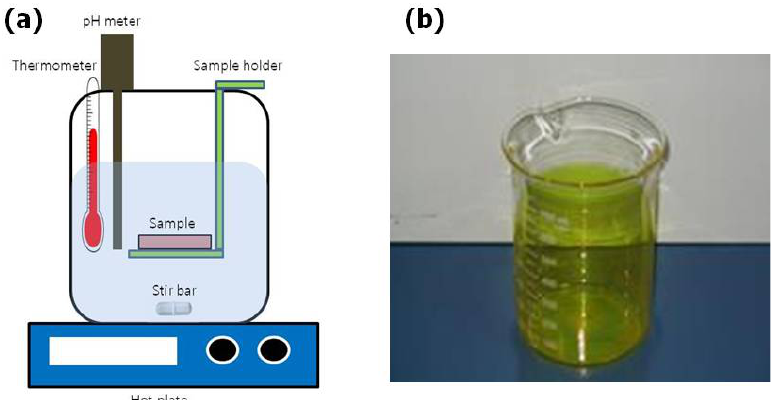
( b ) photograph of a CdS-coated beaker